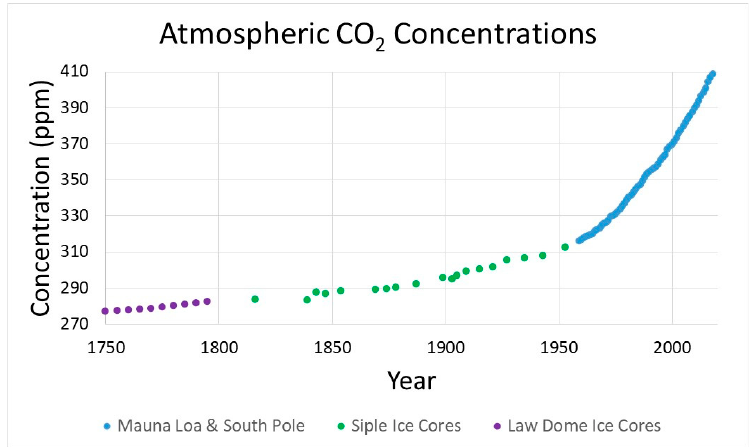
Figure 2. Observations of atmospheric CO 2 concentrations (ppm) [15–18] .